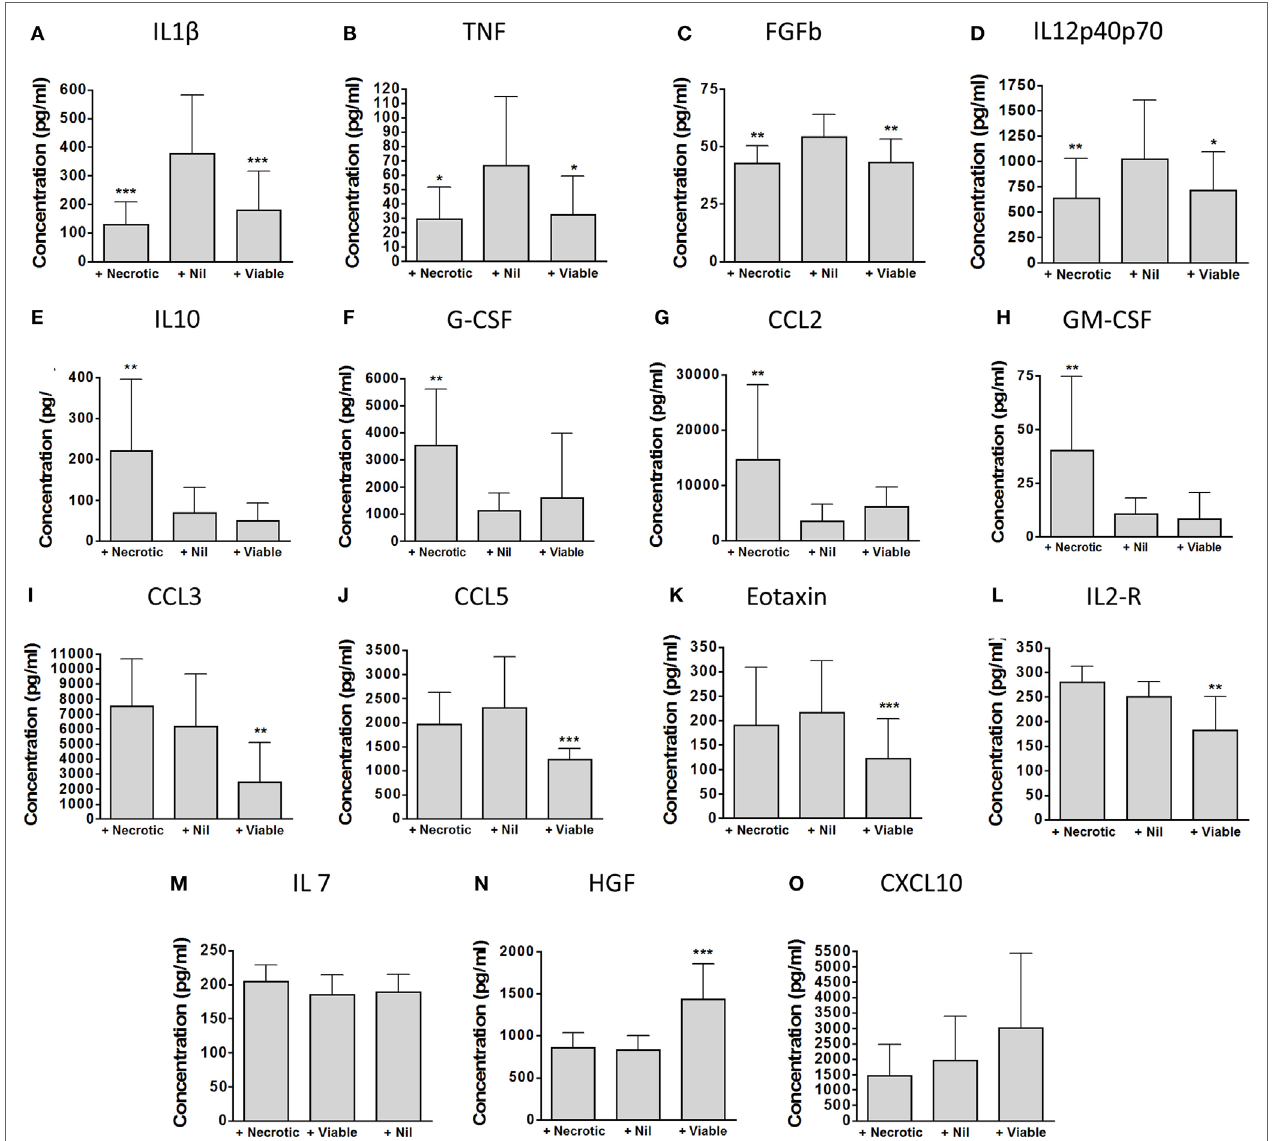
FigUre 4 | Detailed impact of viable and necrotic neutrophil augmentation on supernatant cytokines and chemokines from Mycobacterium tuberculosis - infected blood. (a–O) Cytokines and chemokines were measured in 96-h supernatants of M. tuberculosis -infected blood which had been augmented with necrotic autologous neutrophils (“ + Necrotic”), with medium only (“ + Nil”), or with viable autologous neutrophils (“ + Viable”). Bars represent mean ± SD for each analyte found to be significant in principal component analysis. Presented are p -values from one-way ANOVA with Bonferroni correction comparing both augmented conditions with the medium-only control: * p < 0.05, ** p < 0.01, *** p < 0.001. Data are from nine separate donors in four independent experiments. Abbreviations: IL, interleukin; TNF, tumor necrosis factor; FGFb, fibroblast growth factor basic; G-CSF, granulocyte-colony stimulating factor; GM-CSF, granulocyte macrophage- colony stimulating factor; CCL, C-C chemokine ligand; CXCL, C-X-C motif ligand; IL-2R, interleukin-2 receptor; HGF, hepatocyte growth